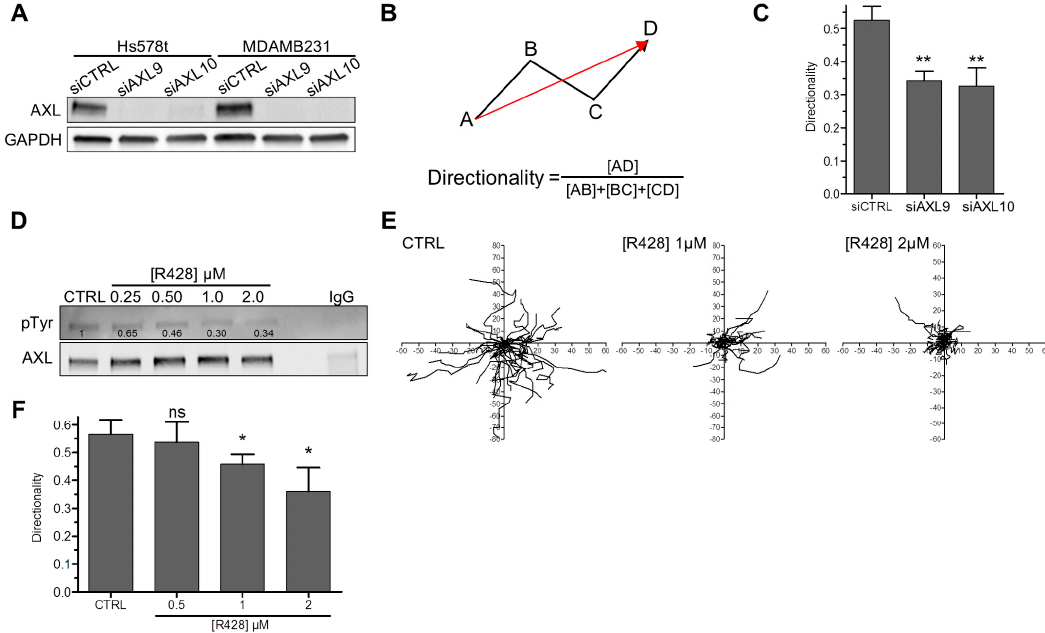
Figure 1. AXL controls directed cell migration. ( A ) AXL protein expression by western blotting in Hs578t and MDA-MB-231 cells three days following transfection with CTRL, AXL9 or AXL10 small interfering RNAs (siRNA). GAPDH was used as a loading control. ( B ) Schematic representation of the method used to measure cell directionality. ( C ) Evaluation of the directionality of Hs578t cells three days after transfection with CTRL, AXL9 or AXL10 siRNA obtained from 110, 100 and 113 cells in three independent experiments, respectively. (** p = 0.003; 0.007). ( D ) Hs578t cells were cultured with serum and treated with DMSO (CTRL) or various concentrations (0.25, 0.5, 1 or 2 µ M) of R428 for 6 h. Basal phosphorylated active AXL was then detected by western blotting using an anti-phosphotyrosine antibody after AXL immunoprecipitation. As a negative control, IgG instead of AXL antibodies were used with cells treated with DMSO. ( E ) Representative migration trajectories of Hs578t cells treated with DMSO (CTRL) or various concentrations (1 or 2 µ M) of R428 for 6 h. ( F ) Directionality of Hs578t cells treated with DMSO (CTRL) or various concentrations (0.5, 1 or 2 µ M) of R428 obtained from 108, 96, 80 and 75 cells in three independent experiments, respectively. (ns > 0.05, * p = 0.012; 0.024). All graphs represent means and small bars indicate standard